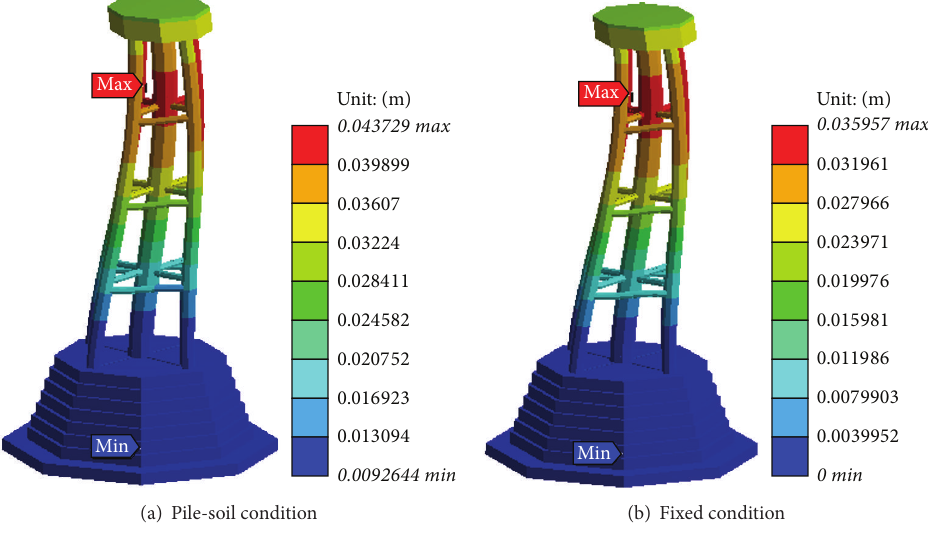
Figure 12: Comparison of displacements with irregular wave at